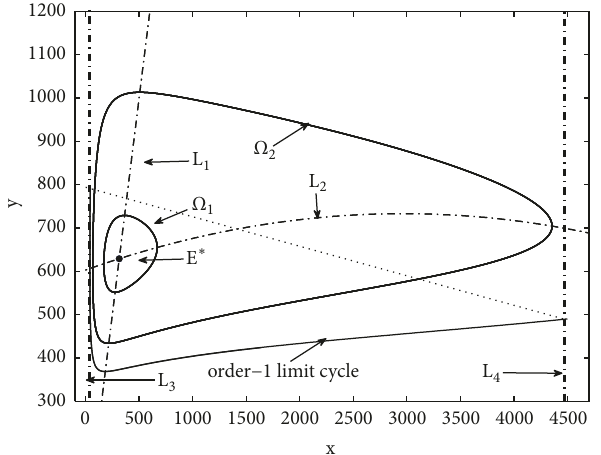
Figure 6: Coexistence of the limit cycles and an order- 1 limit cycle with 𝑟 = 0.0314425 , 𝐾 = 10000 , 𝑚 = 0.2123448512 , 𝐴 = 4070.34 , 𝑠 = 0.00128 , ℎ = 0.5 , 𝐸𝑇 = 4500 , 𝛿 = 0.99 , 𝜎 = 100 , and 𝑞 = 0.4